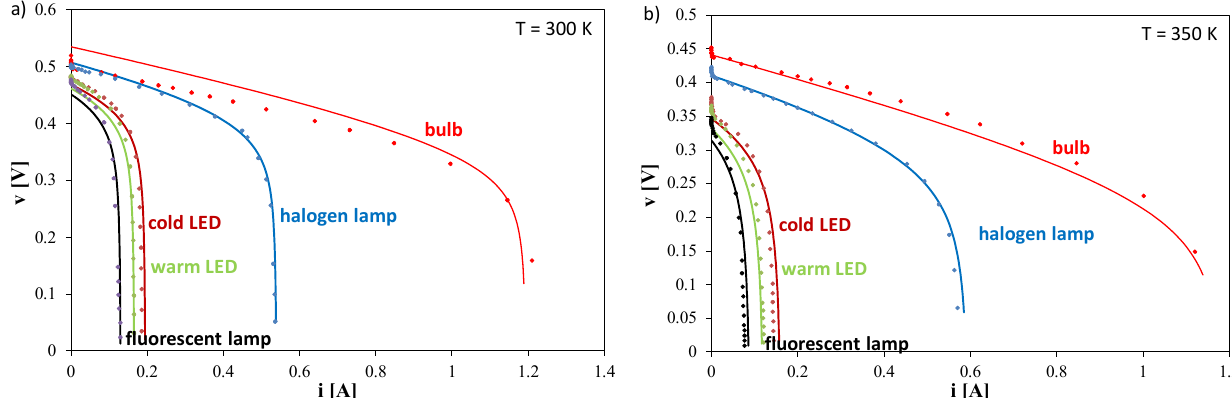
Figure 7. The measured and computed current–voltage characteristics of the monocrystalline solar cell irradiated by the considered lighting sources at temperature T = 300 K ( a ) and T = 350 K ( b ).